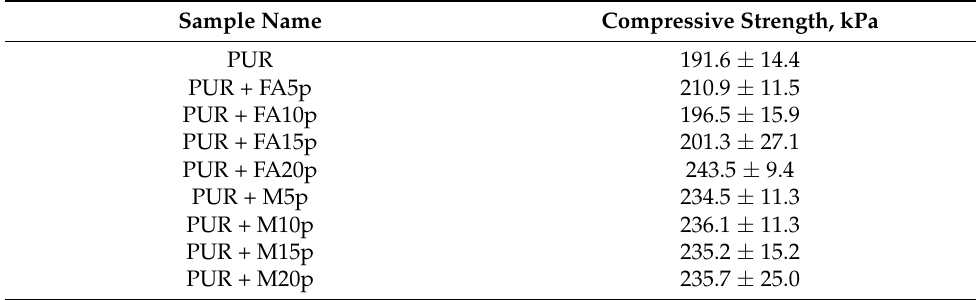
Table 5. Mechanical properties of the PUR foams calculated from stress-strain curves.